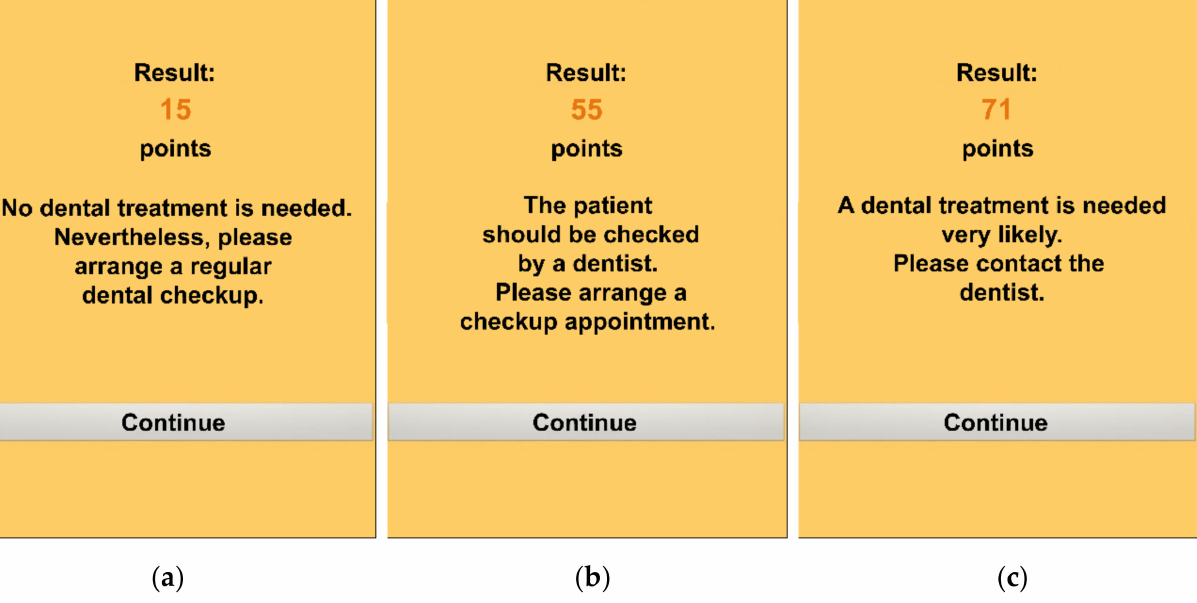
Figure 4. Screenshot of the digital MDA displaying the three possible results of the assessment: ( a ) 10–30 points, ( b ) 31–60 points, ( c ) >60